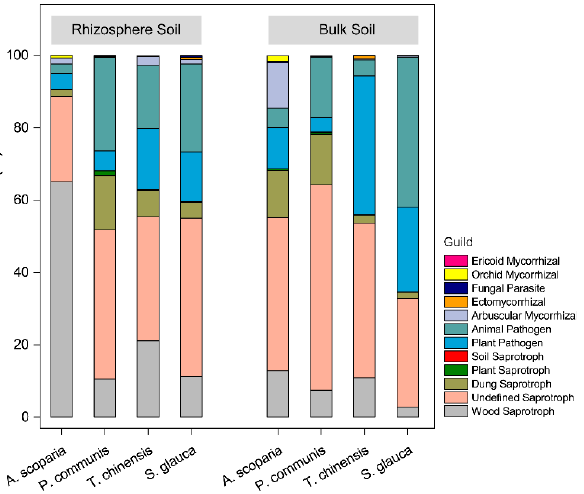
Figure 4. Relative abundance of fungal guilds in the rhizosphere and bulk soil of the four selected plant species.